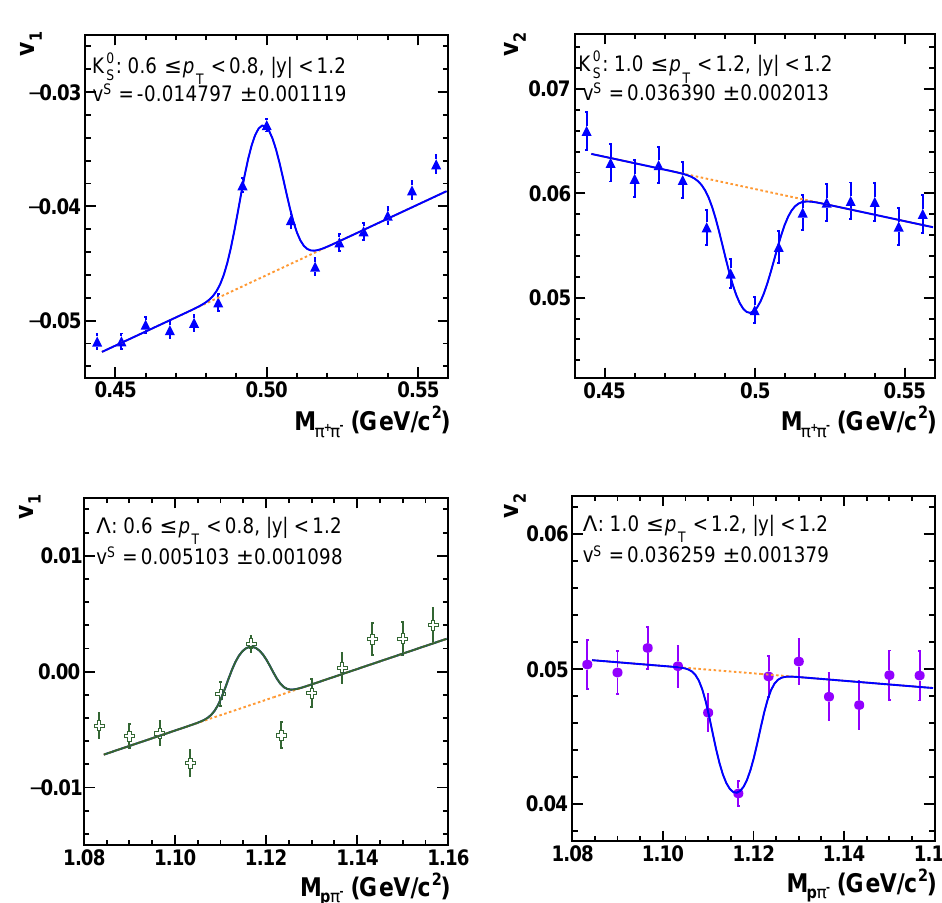
Figure 8. The demonstration of the invariant-mass fit method to extract the v S ( right panels) signals for K 0 ( upper part) and Λ ( lower part) particles for 10–40% central Au + Au S √ s NN = 11 collisions at